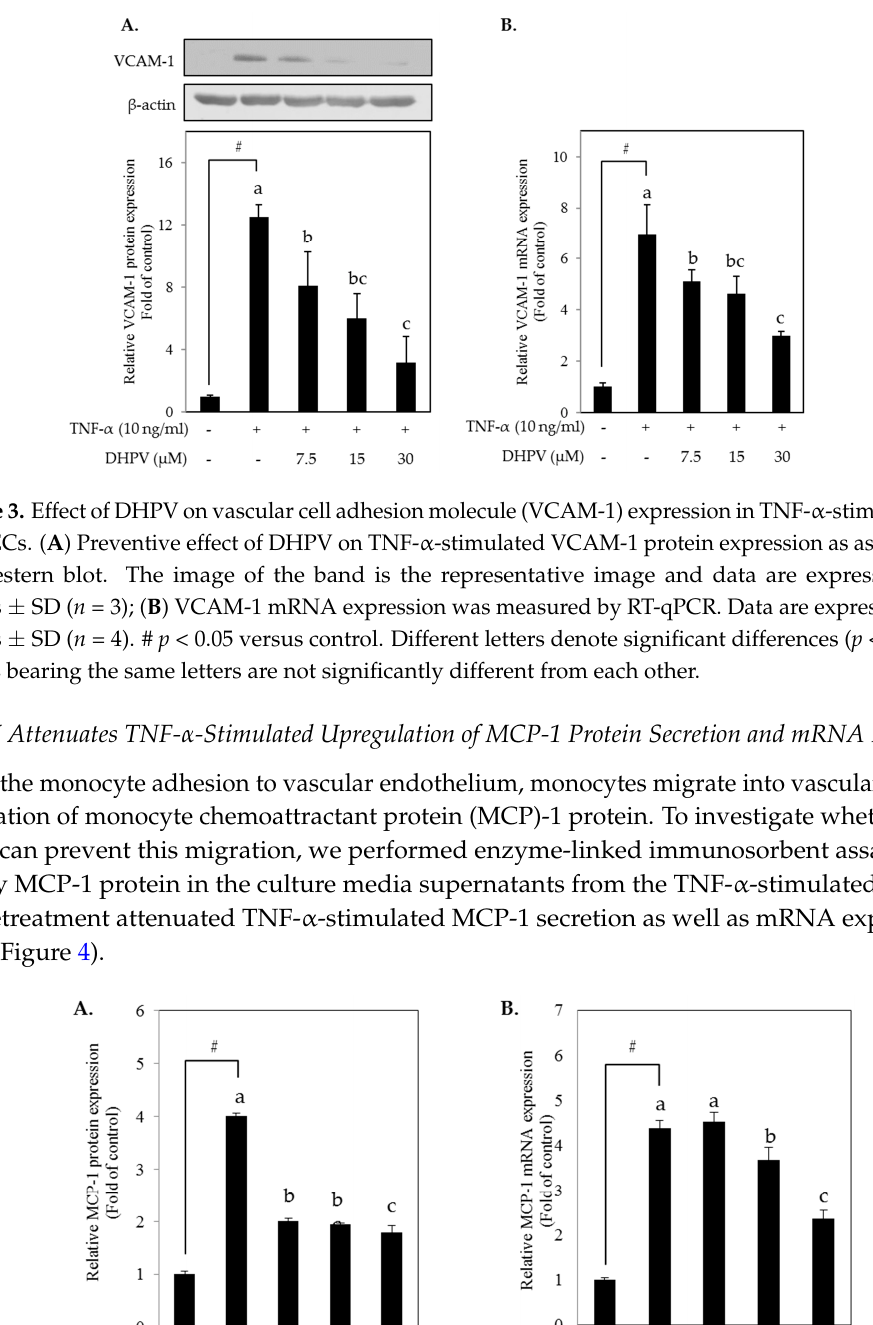
Figure 5. Effect of DHPV on TNF- α -induced NF- κ B transcriptional activity. Following pretreatment with DHPV and TNF- α -stimulation, NF- κ B transcriptional activity was measured in HUVECs transfected with NF- κ B luciferase reporter plasmids. Data are expressed as means ± SD ( n = 4). # p < 0.05 versus control. Different letters denote significant differences ( p < 0.05); values bearing the same letters are not significantly different from each other.